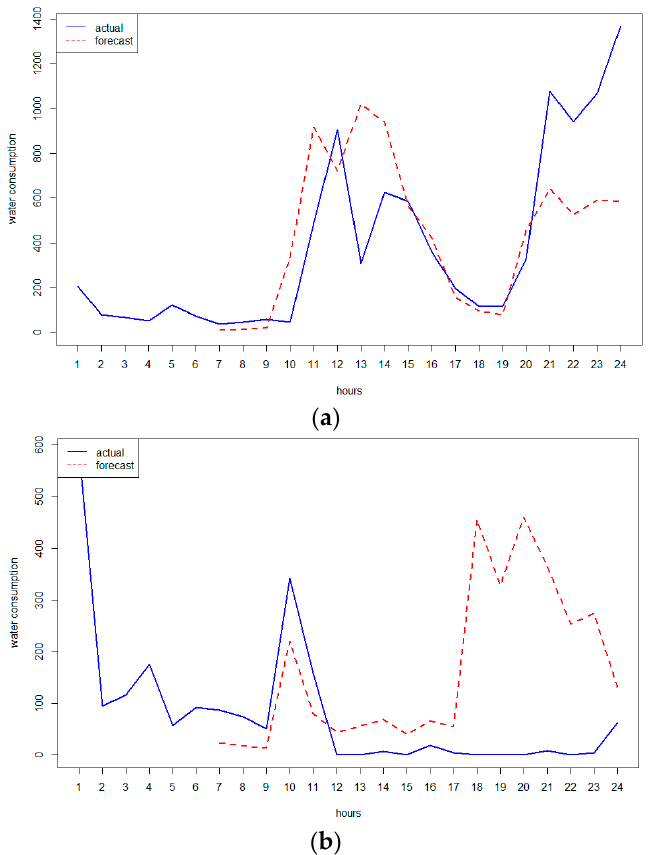
Figure 14. Case 2—actual consumption versus forecast for the day with the lowest ( a ) and highest ( b ) MAPE.